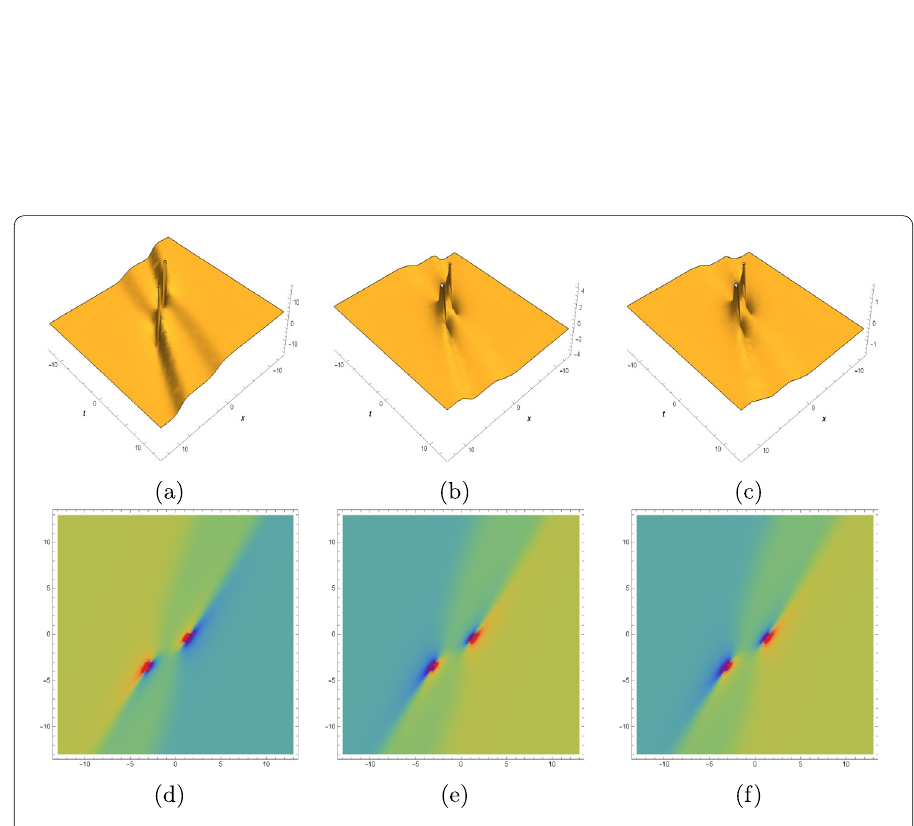
Figure 4 The 3D and density profiles of imaginary part of Eq. (11) for b 2 = 1.23, b 3 = 2.04, b 7 = 2.19, T 1 = 1, T =